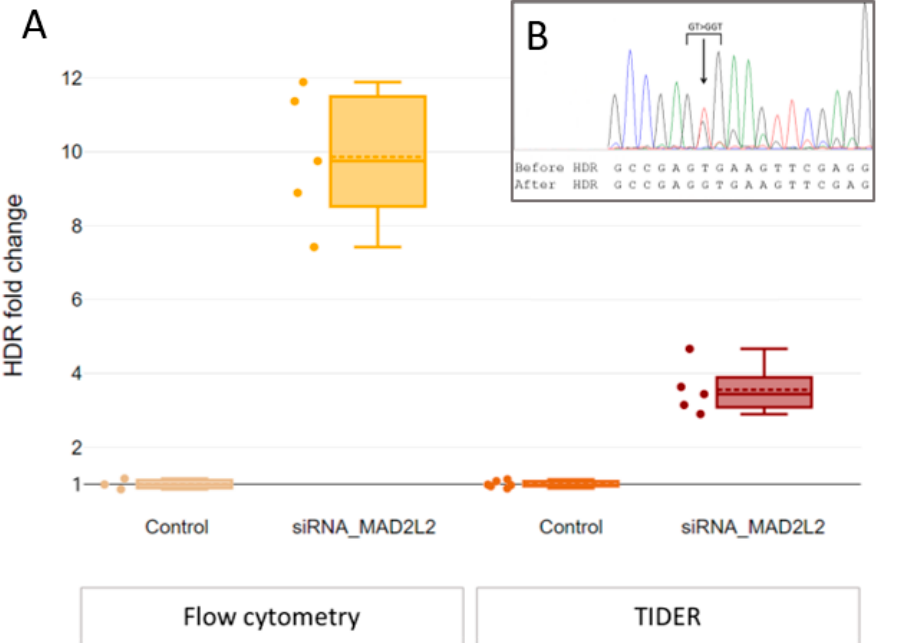
Figure 2. MAD2L2 knockdown increases HDR e ffi ciency (dashed line represents mean, solid